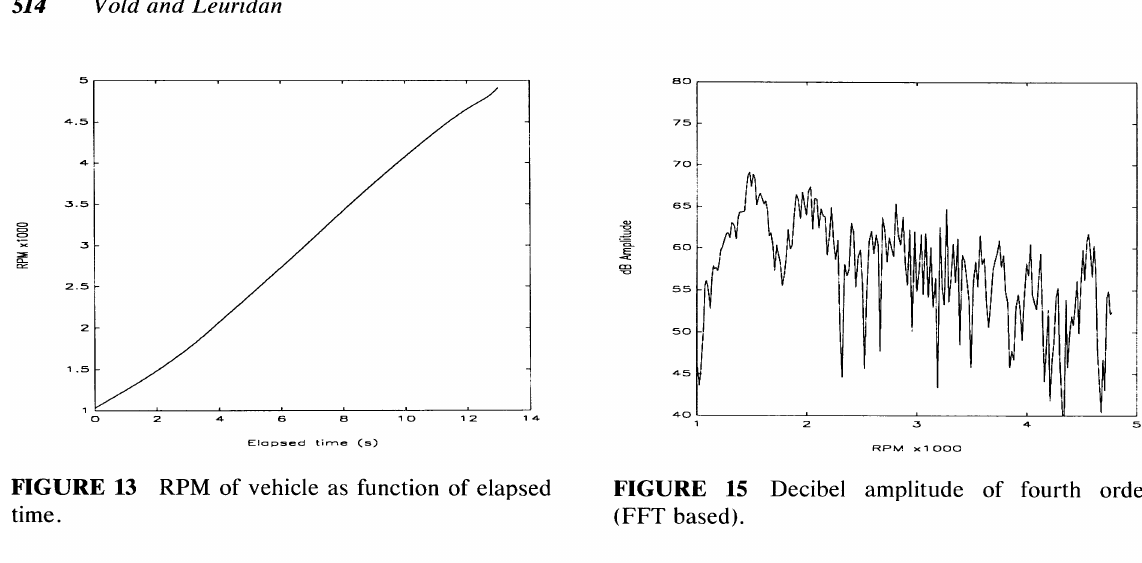
FIGURE 15 Decibel amplitude of fourth order (FFT based).